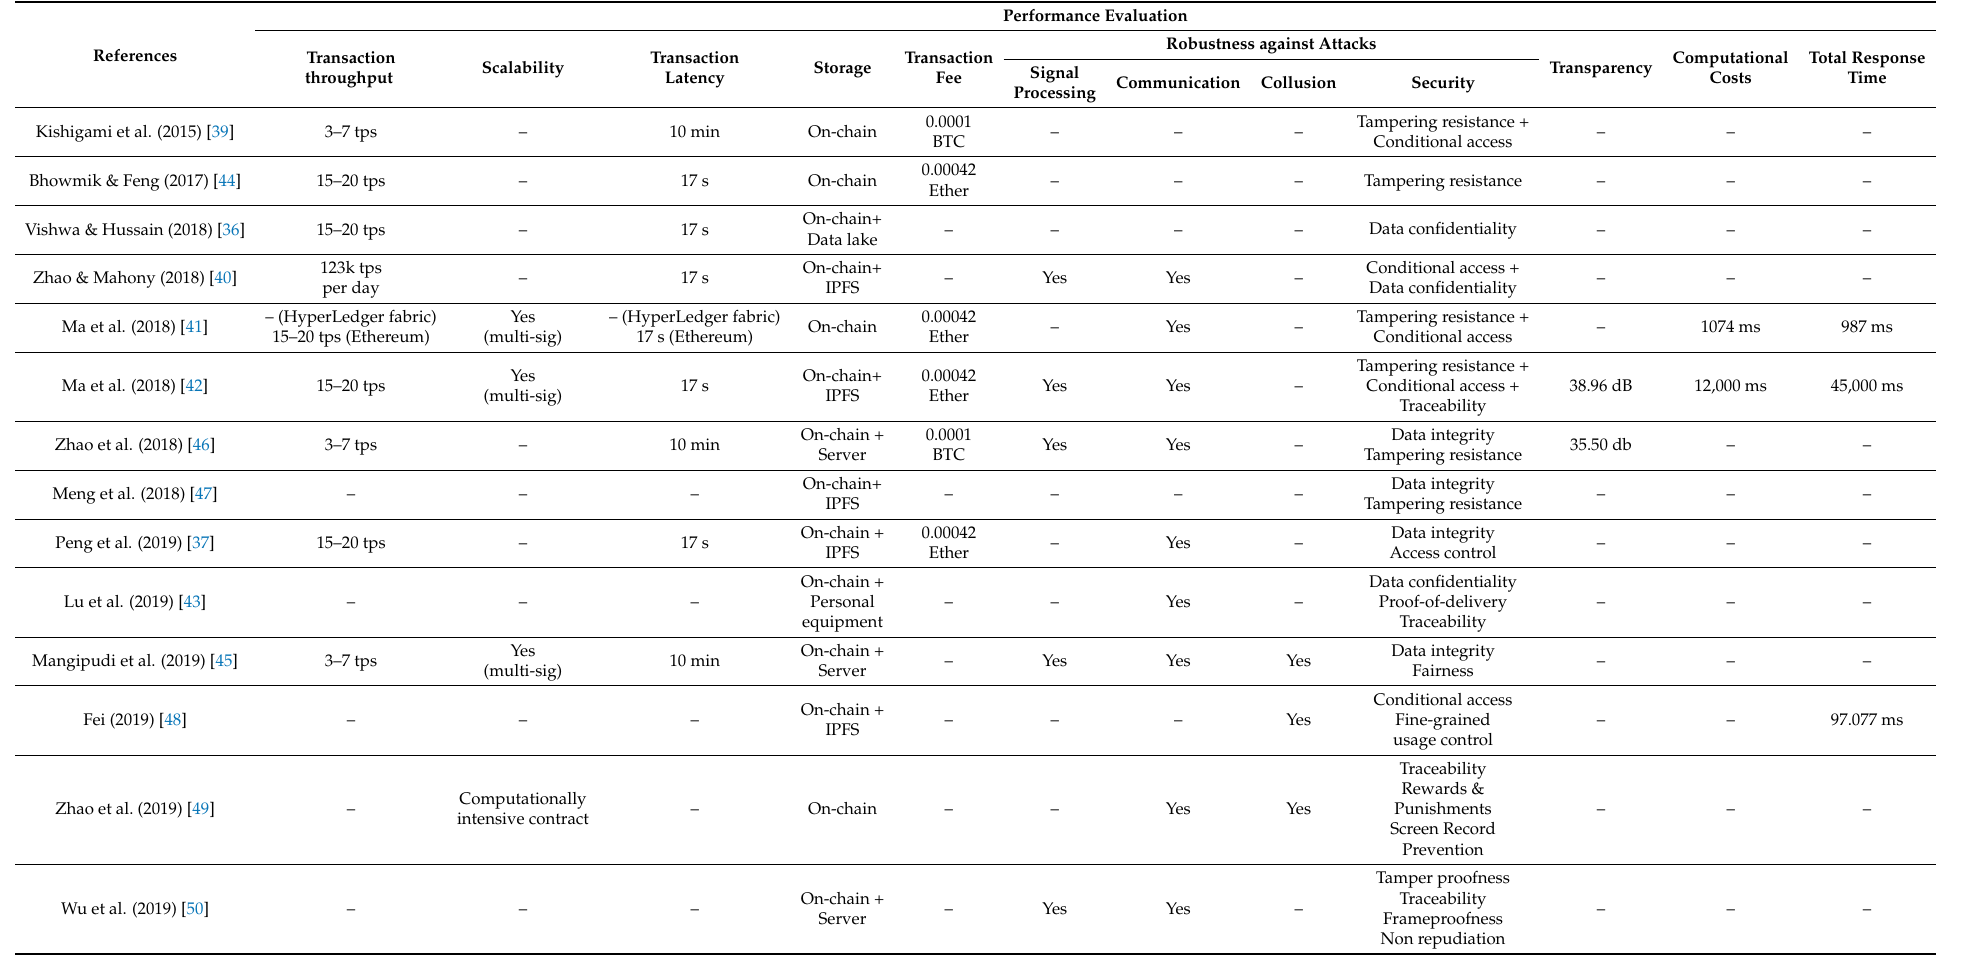
Table 2. Comparison of the blockchain-based multimedia content protection schemes with reference to the performance